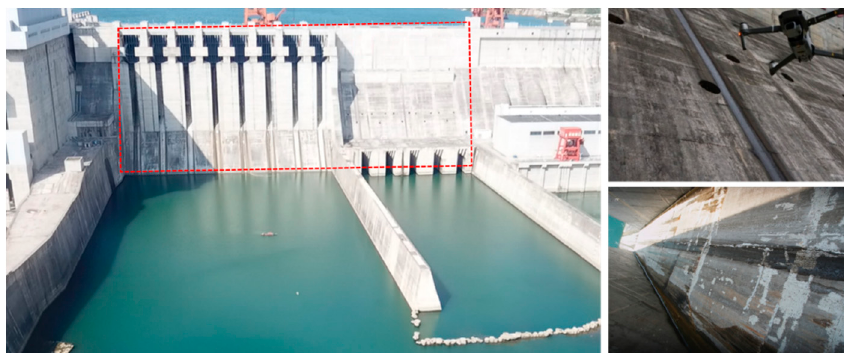
Figure 6. A dam of hydropower station in Jialing River Basin. Table 1. Dam surface image collection equipment and environmental parameters.